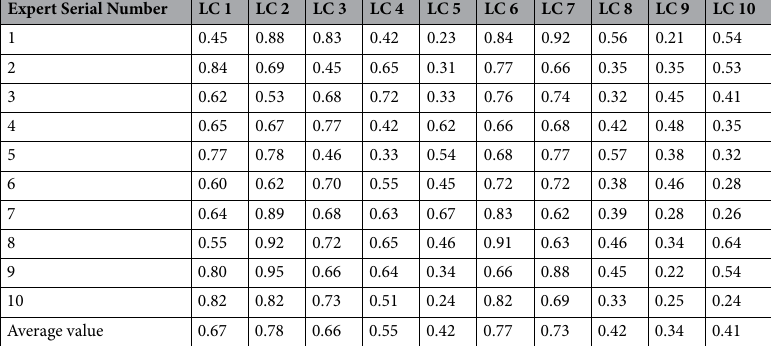
Table 5. Qualitative indicator U14 expert score summary